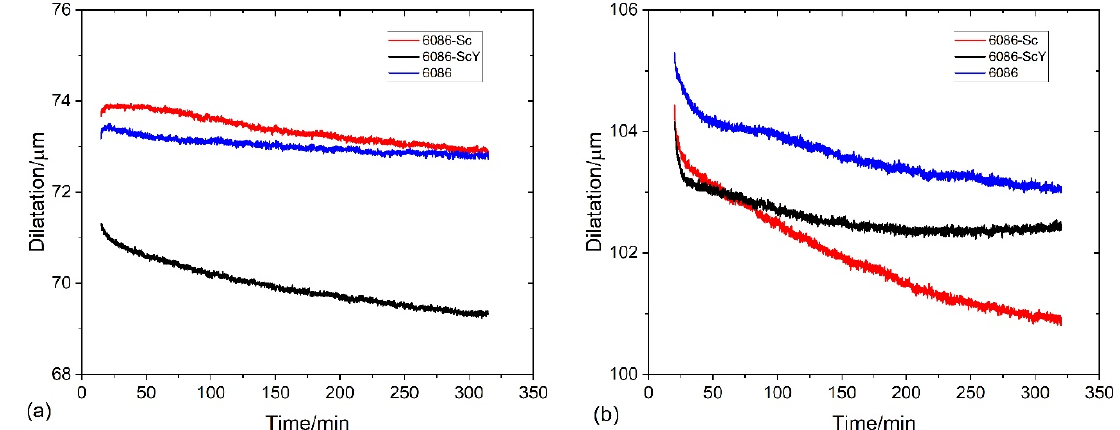
Figure 22. The results of the dilatometry during isothermal annealing ( a ) at 300 °C, ( b ) at 400 °C.